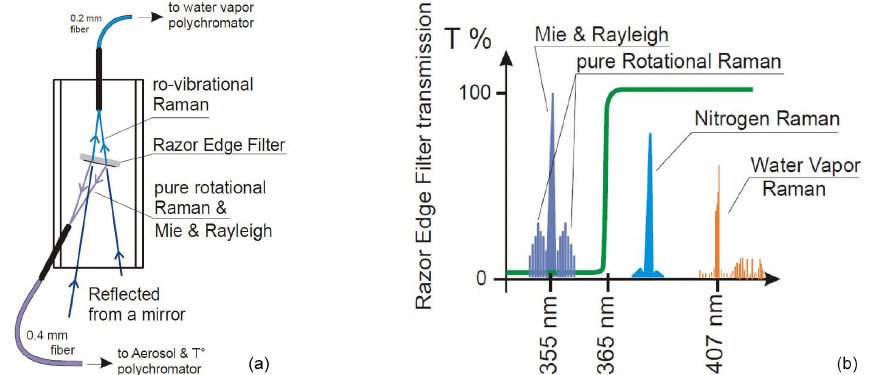
Figure 5. (a) Telescopic mirrors, RazorEdge filter and optic fibres. (b) The REF cut-off frequency applied to the 355nm Raman spectrum. Table 1. Theoretical polychromator efficiencies ( ξ ) for the nitrogen PRR lines at wavelengths λ . Nitrogen J low J high J anti-Stokes ( n low